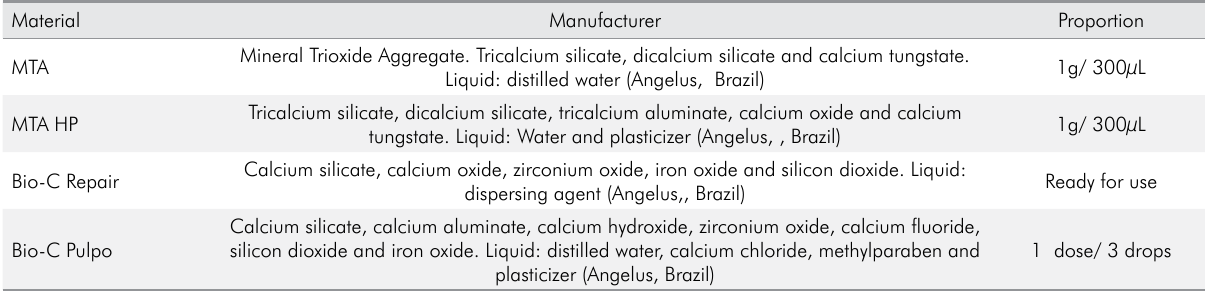
Table. Materials and proportions